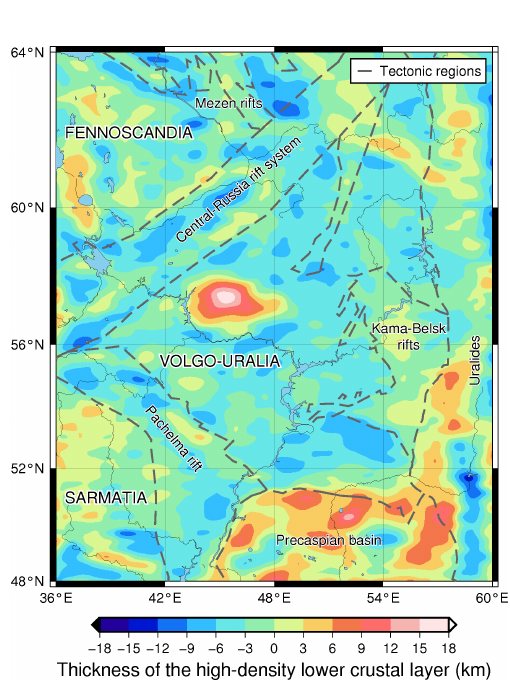
Figure 10. Thickness of the high-density lower crustal layer from the isostatic calculations.